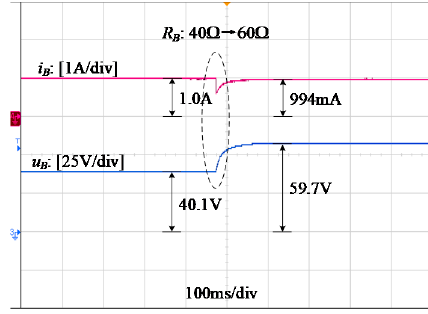
Figure 14. Transient waveforms switch from 40 Ω to 60 Ω at CC mode .